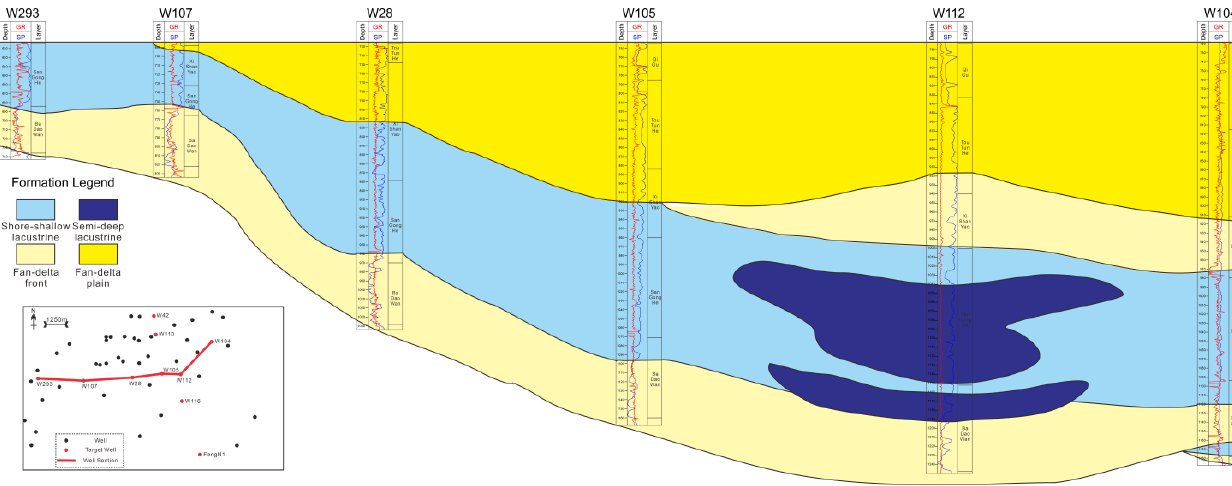
Figure 8. Sedimentary facies diagram of an east – west connecting